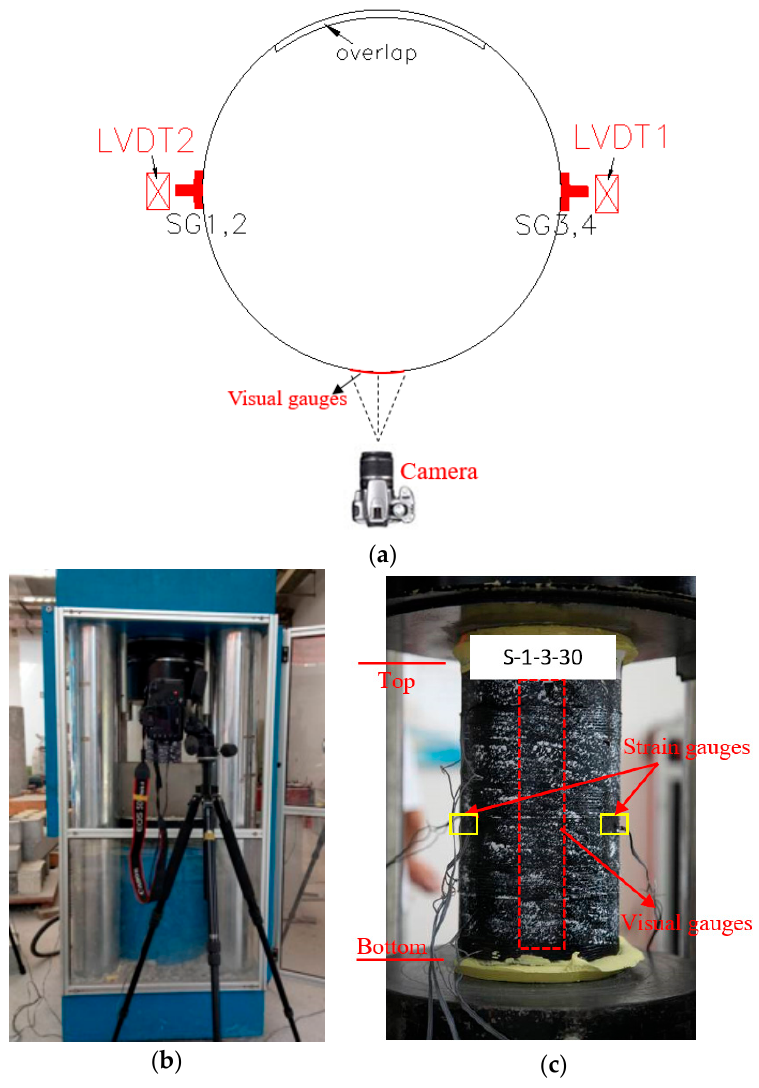
Figure 6. Instrumentations. ( a ) Location of cameras, foil strain gauges and LVDTs; ( b ) The system of PIV image acquisition; ( c ) Visual gauges and foil gauges.